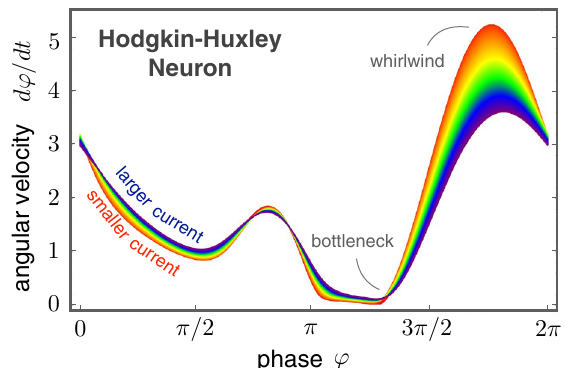
Figure 4. Nonuniform phase dynamics in the Hodgkin-Huxley neuron. The angular velocity �(ϕ) exhibits a highly non-trivial dependence on the U(1) phase. In the regime of current stimuli from 6.3 µ A/cm 2 (red) to 46.3 µ A/cm 2 (blue), one finds the overall shape remains more or less the same. However, because the firing rate is dictated by the bottleneck regime, a slight increase of the angular velocity here will boost up the firing rate